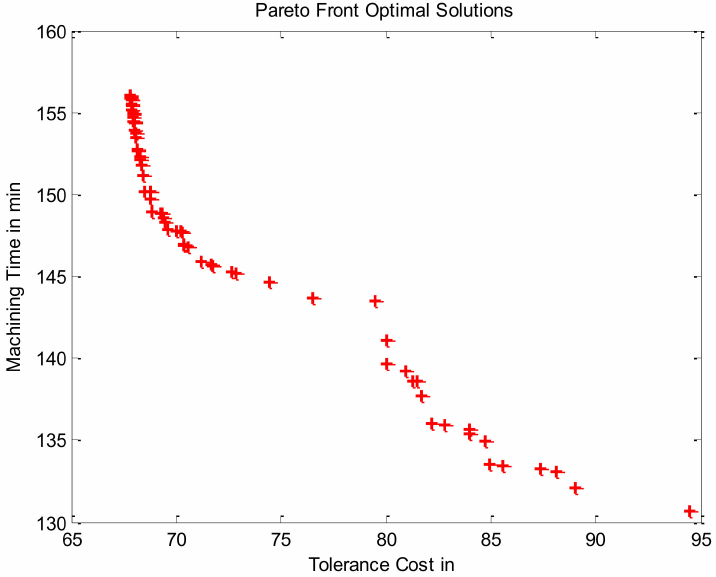
Figure 10. Optimum Pareto front